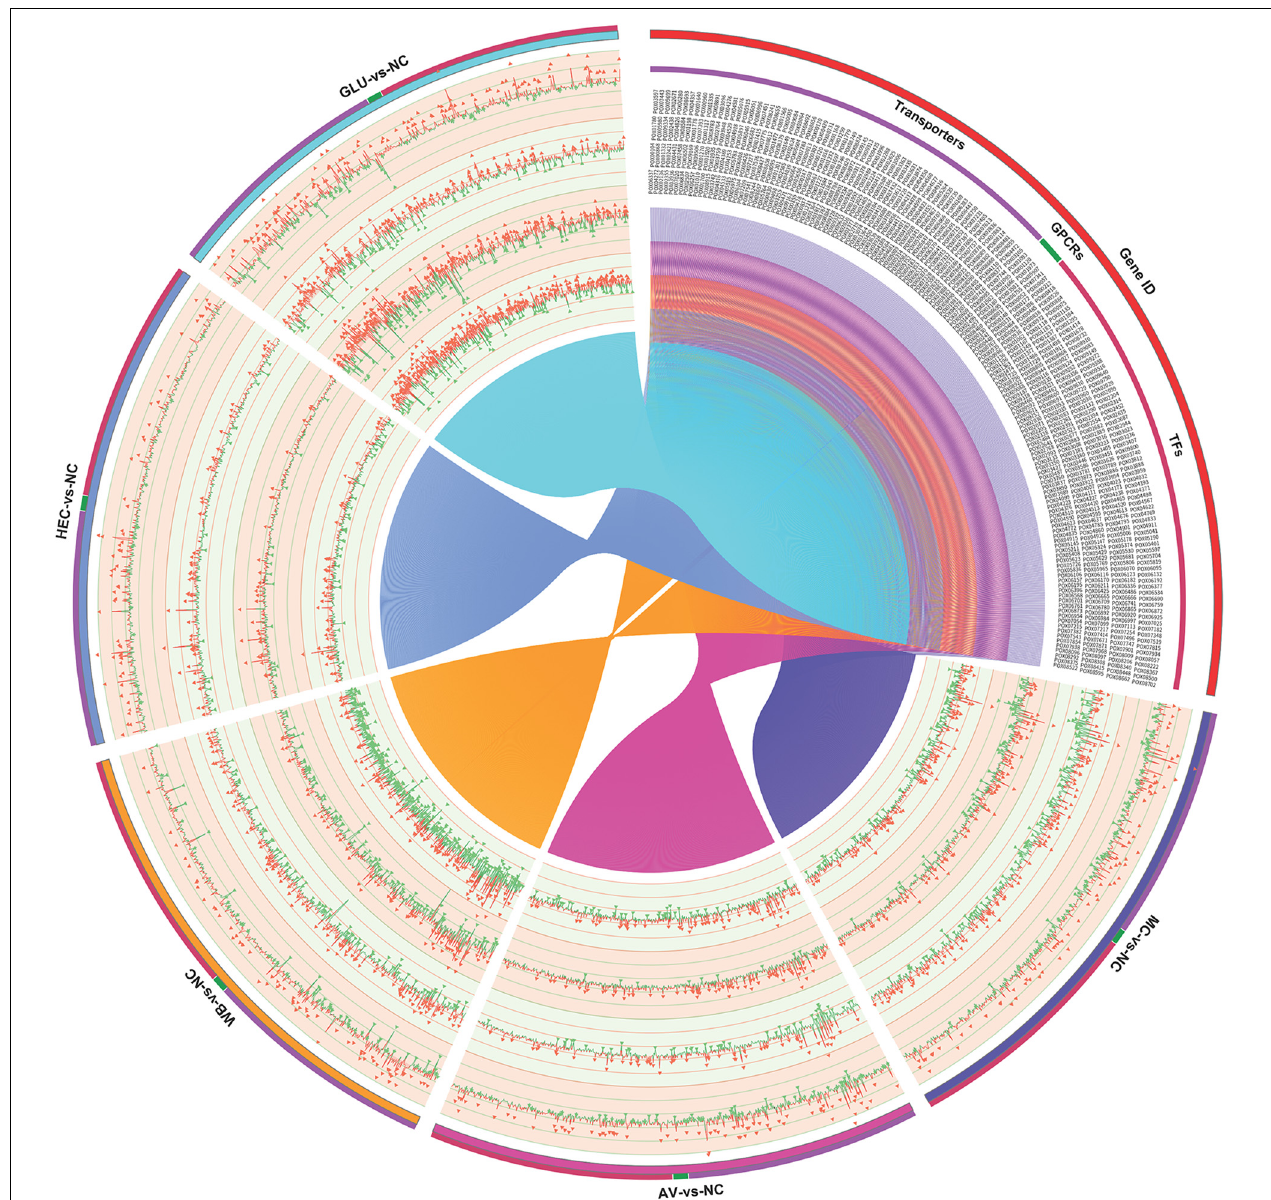
FIGURE 6 | Expressional analysis of genes encoding transcription factors, transporters and G protein-coupled receptors in P. oxalicum on different carbon sources (AV, MC, HEC, WB, and GLU) compared with NC. AV, Avicel; MC, methyl cellulose; HEC, 2-hydroxyethyl cellulose; GLU, glucose; NC, no carbon source; TFs, transcription factors; GPCRs, G-protein coupled